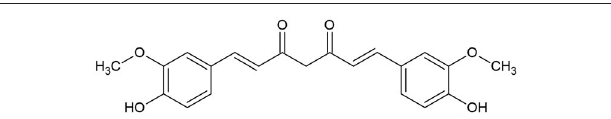
FIGURE 4 | Curcumin chemical structure.